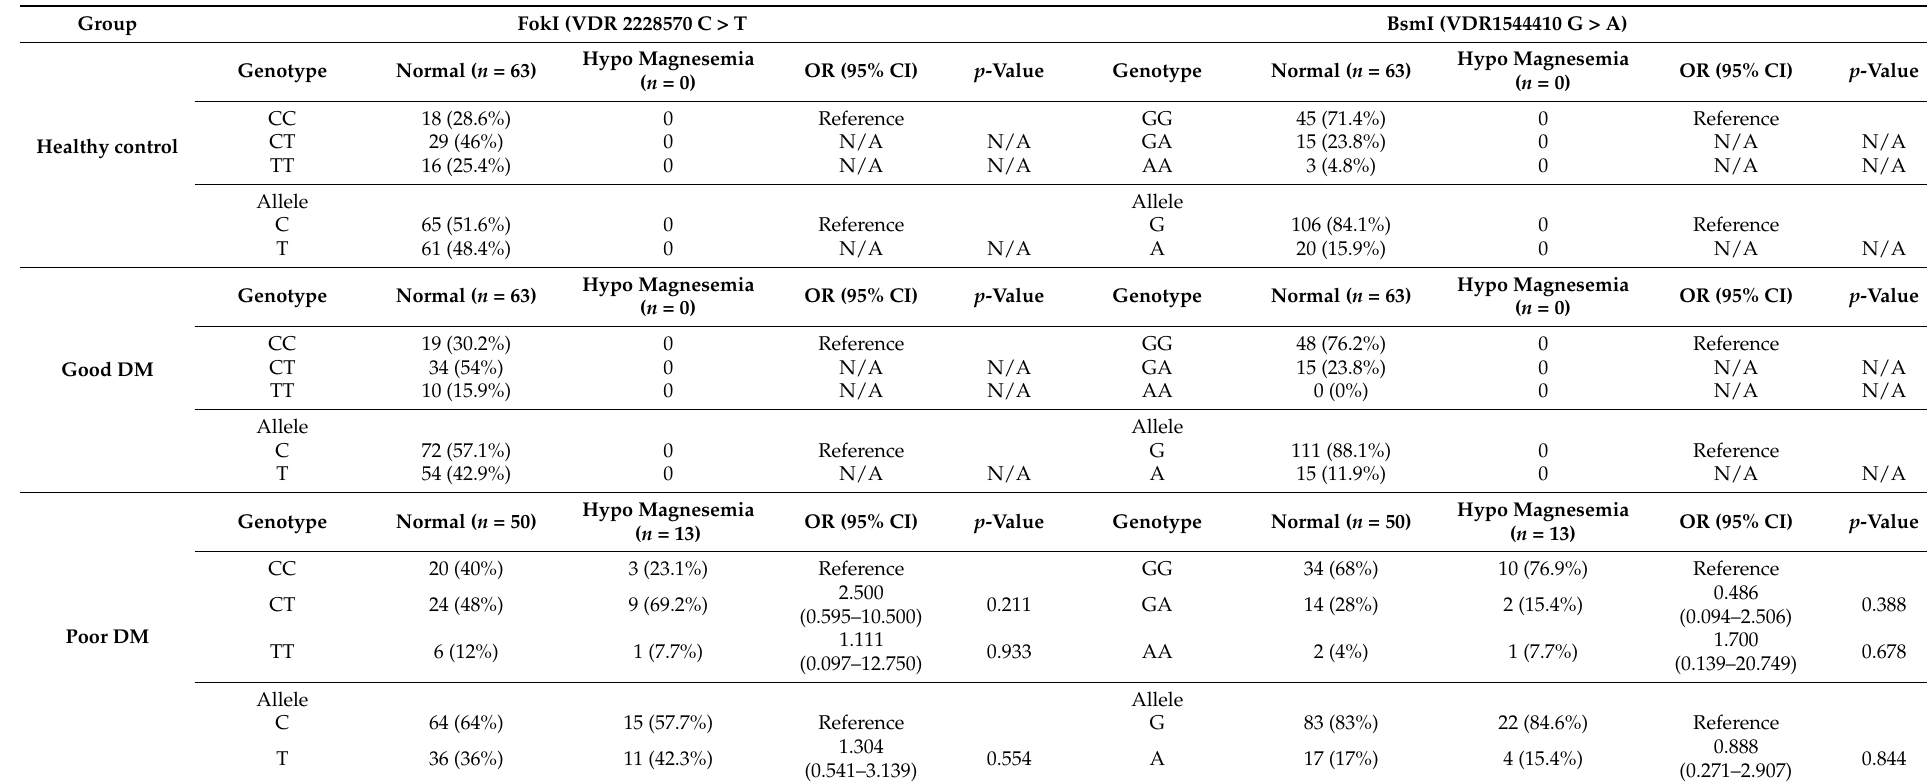
Table 6. Association between VDR polymorphism at FokI (VDR 2228570 C > T) and BsmI (VDR1544410 G > A) and risk of